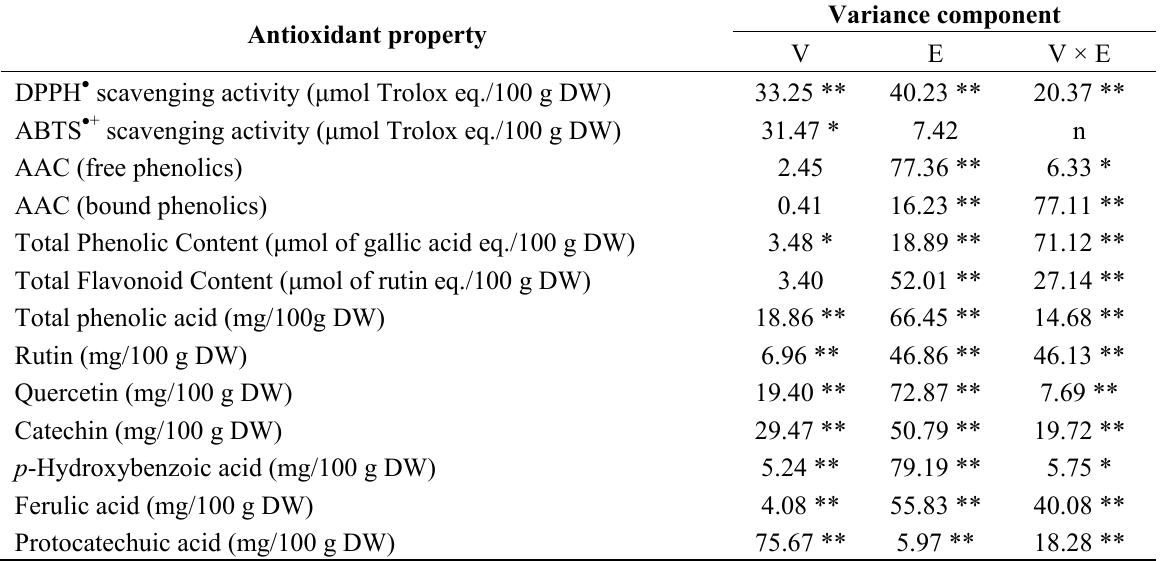
a Results expressed as percent of total variation (mean squares) from factorial design ANOVA using variety and environment as fixed effects. Results with asterisks were significant at P < 0.05; *, significant ( P <